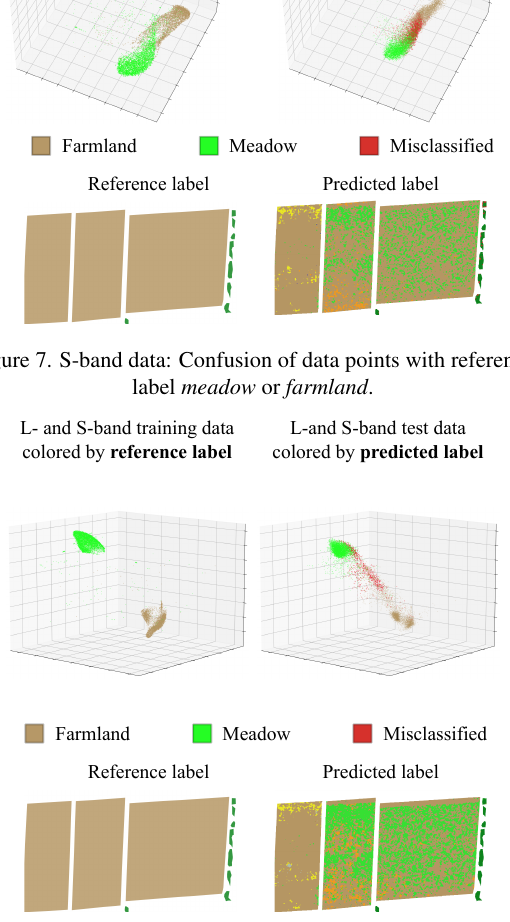
Figure 8. L- and S-band data: Confusion of data points with reference label meadow or farmland